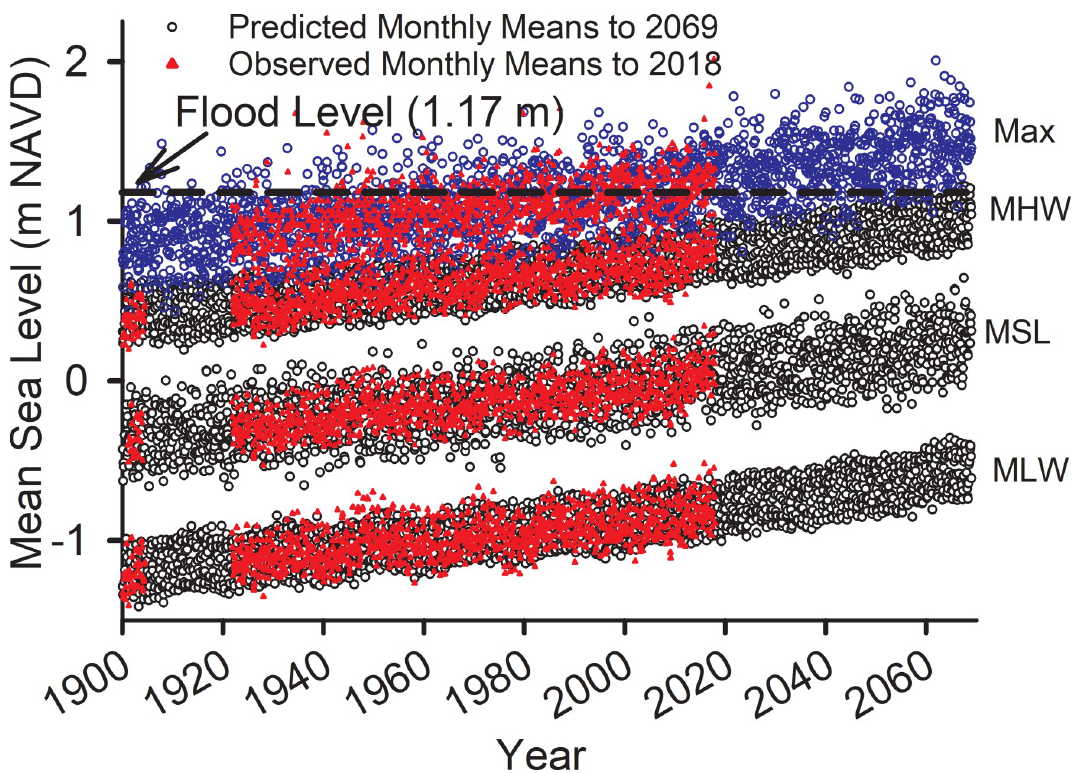
Fig 3. Observed and predicted monthly water levels. Observed and predicted monthly water levels with MLW, MSL, MHW and monthly maximum water level (from Eqs 1–4) with seasonal and decadal harmonics forecasted to year 2068 using a Monte-Carlo procedure with additive monthly and daily perturbations from the residuals of the model